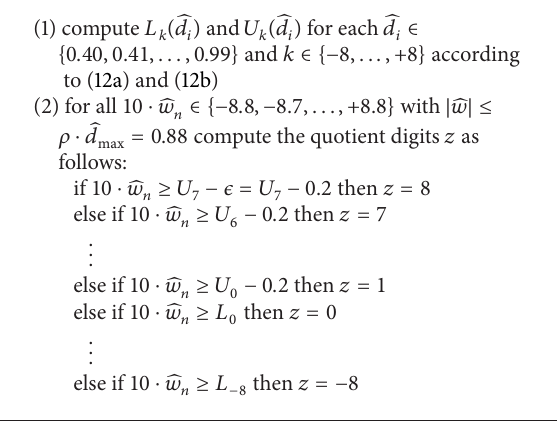
Algorithm 2: Algorithm for the calculation of the type2 ROM